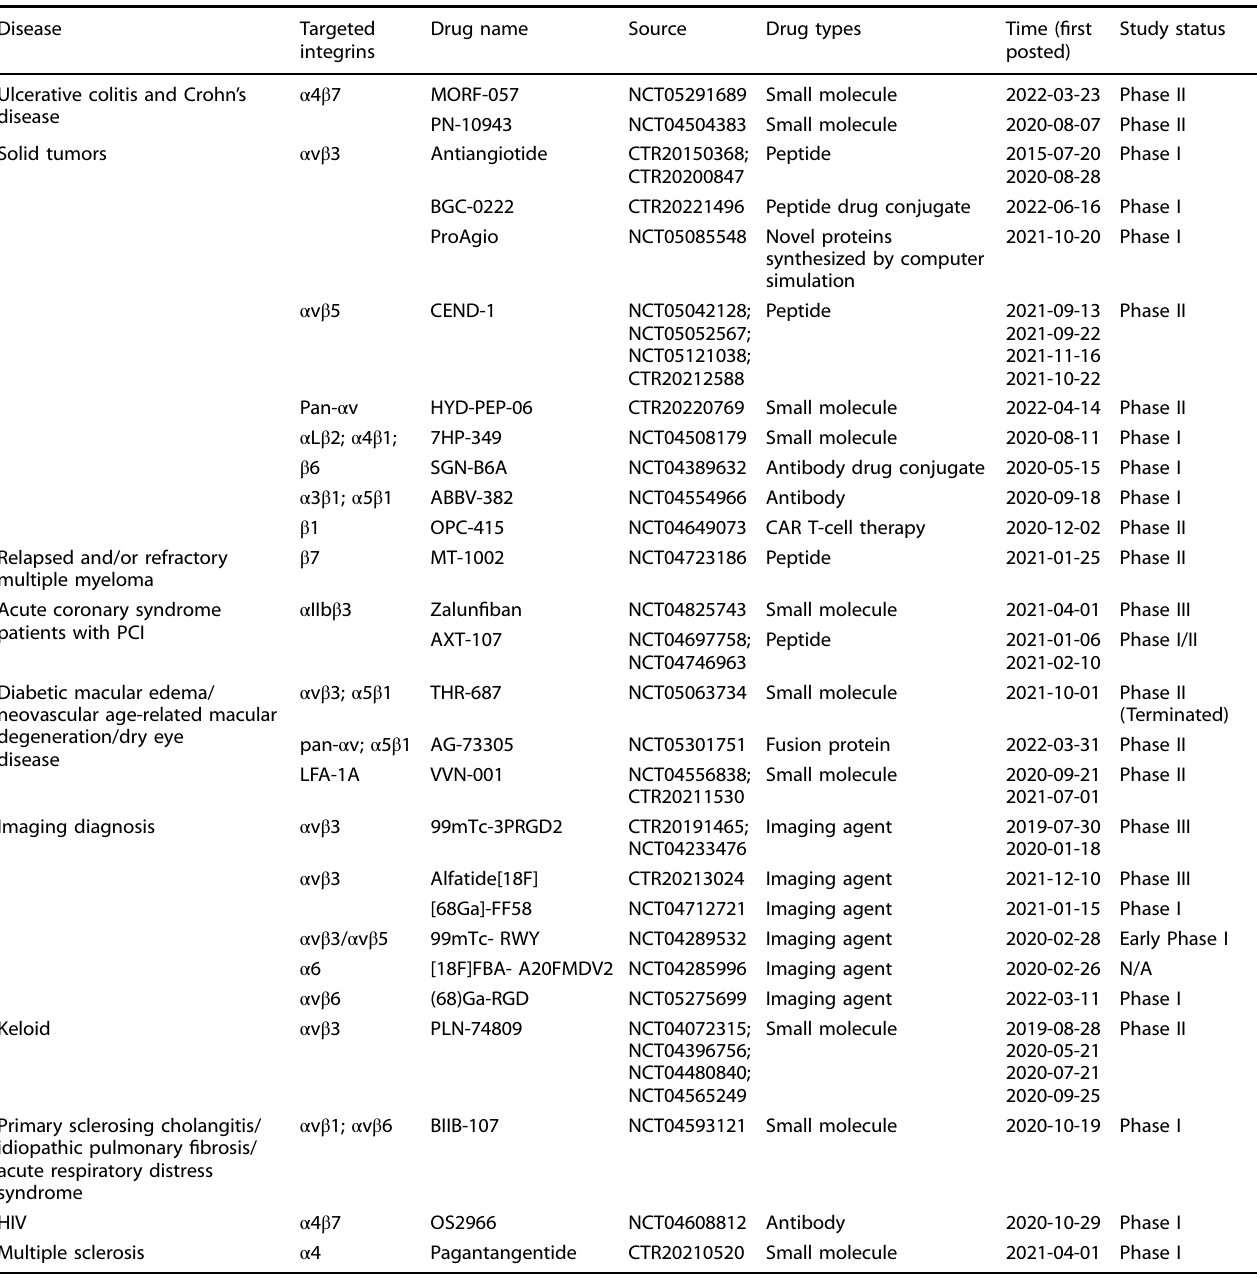
Table 3. Recent integrin-targeting drugs intended as disease therapies in ongoing clinical studies (2019 – 2022)